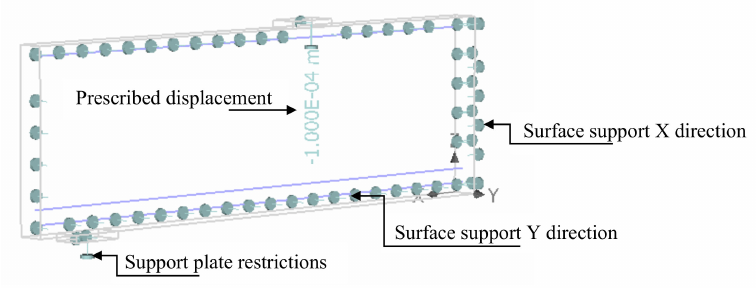
Figure 17. Boundary